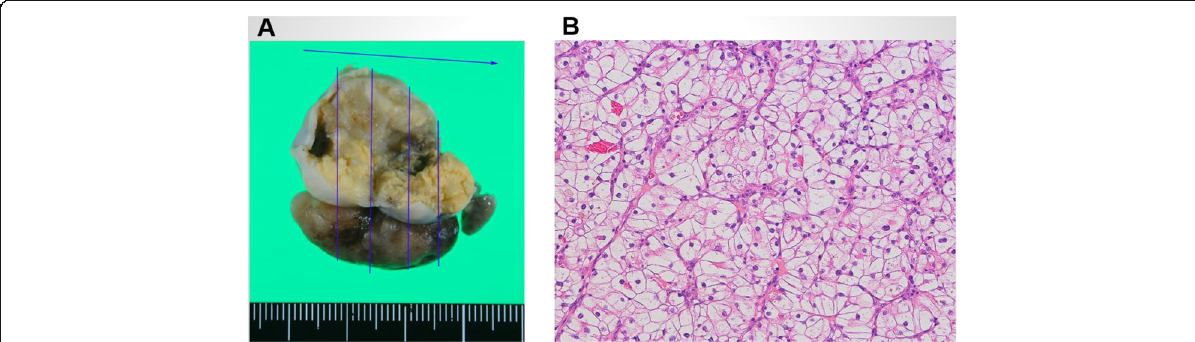
Fig. 3 a Excised cardiac tumor after autopsy. b Microscopy image revealed a lot of proliferation of clear cytoplasm with abundant glycogen, which indicated the metastatic tumor from clear cell renal cell carcinoma (HE stains ×